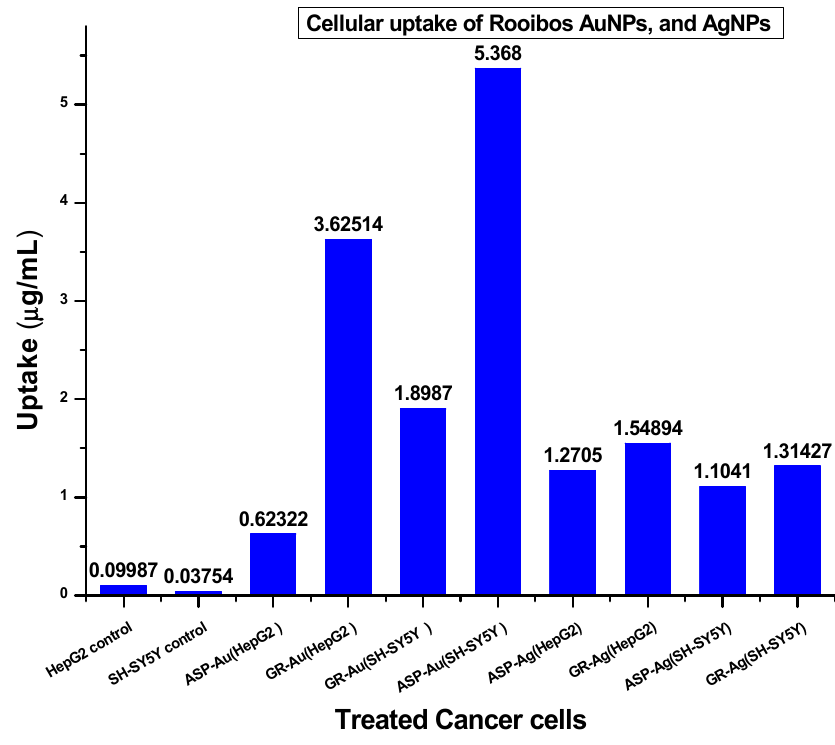
Figure 10. ICP-OES measurements of the cellular uptake of GR/ASP AuNPs and AgNPs.